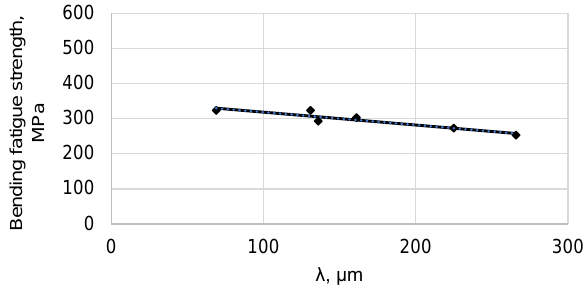
Figure 4: Bending fatigue strength of steel hardened and tempered at 500 ∘ C subject to impurities space